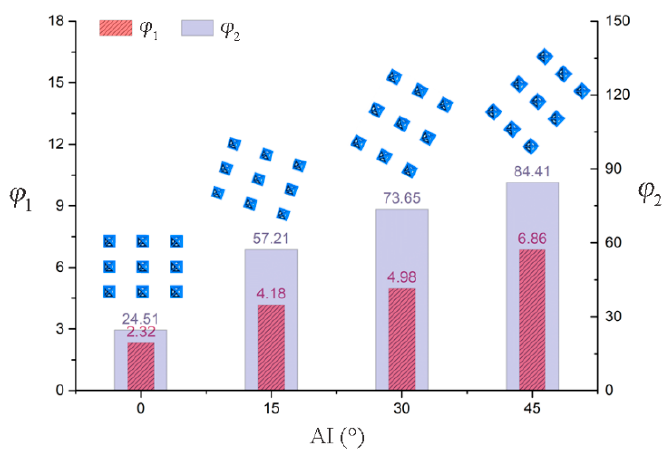
Figure 14. Upwelling and wake efficiency indices of the optimal URs with AI of 0°, 15°, 30°, and 45° .